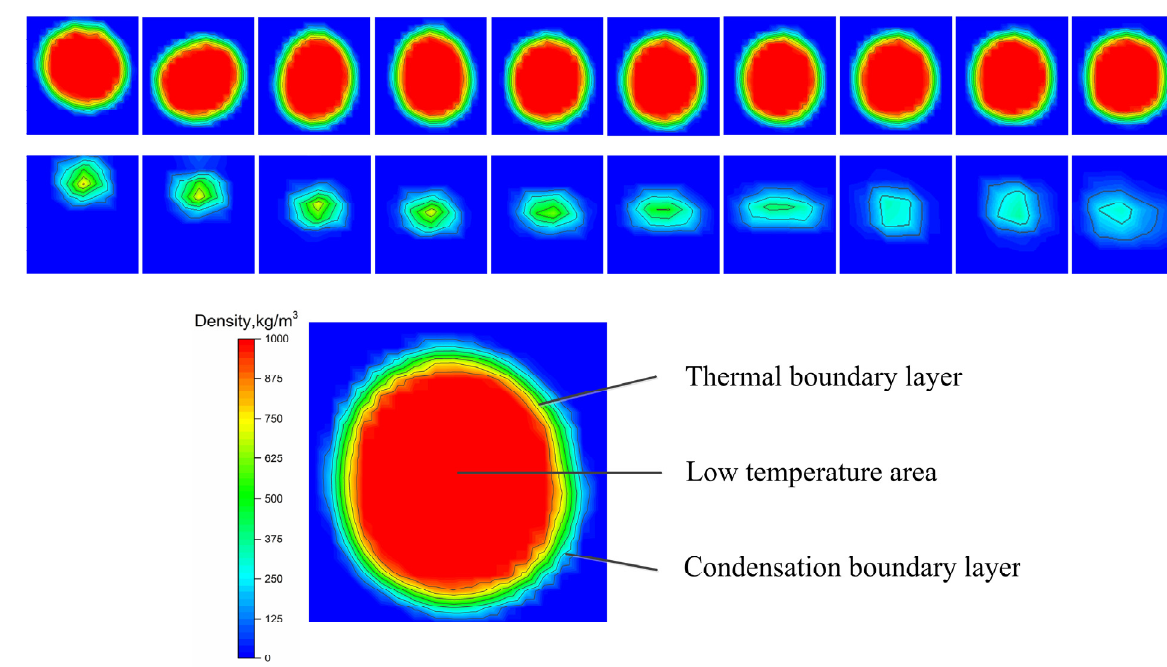
Figure 4. Density contour of a falling droplet.